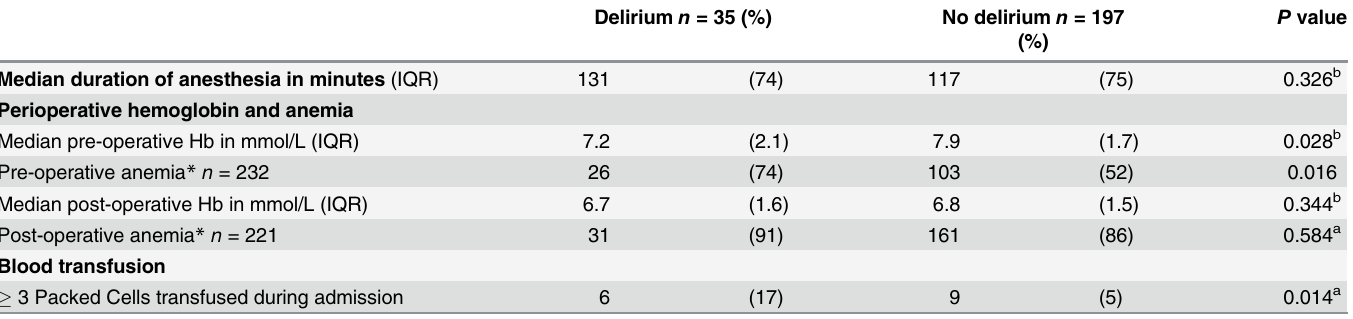
Table 3. Data on anesthesia, hemoglobin and blood transfusion in relation to onset of postoperative delirium of all included patients having elec- tive surgery.